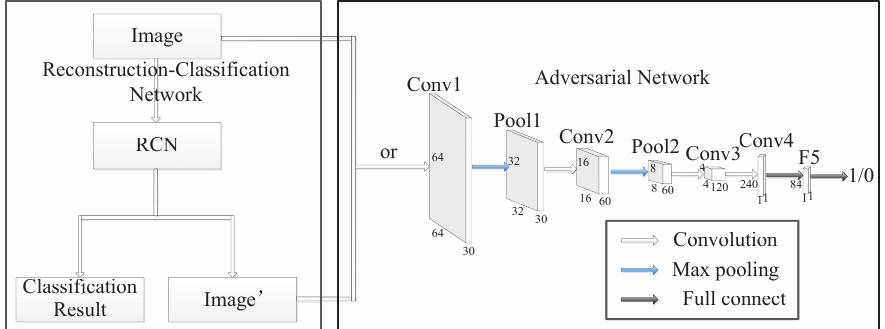
Figure 2. Diagram of ARCN. ( Left ): Reconstruction-classification network (RCN) takes Image as input and produces the classification result and the reconstruction result of Image (Image’), which is shown in Figure 1. ( Right ): Adversarial network takes Image or Image’ as input and produces class label (1 = true image, or 0 = synthetic), where Conv denotes the convolutional layer, Pool denotes the max pooling layer, F denotes the full connected layer, and three color (including white, blue and black) arrows denote the convolution, max pooling, and full connect operation, respectively.